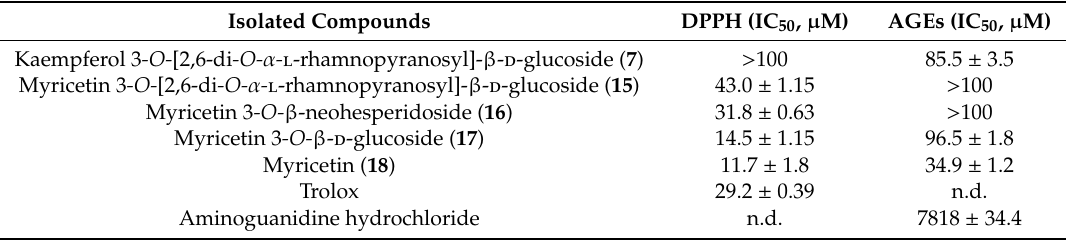
Table 3. Bioactivities of 7 and 15 – 18 from C. rotundifolia